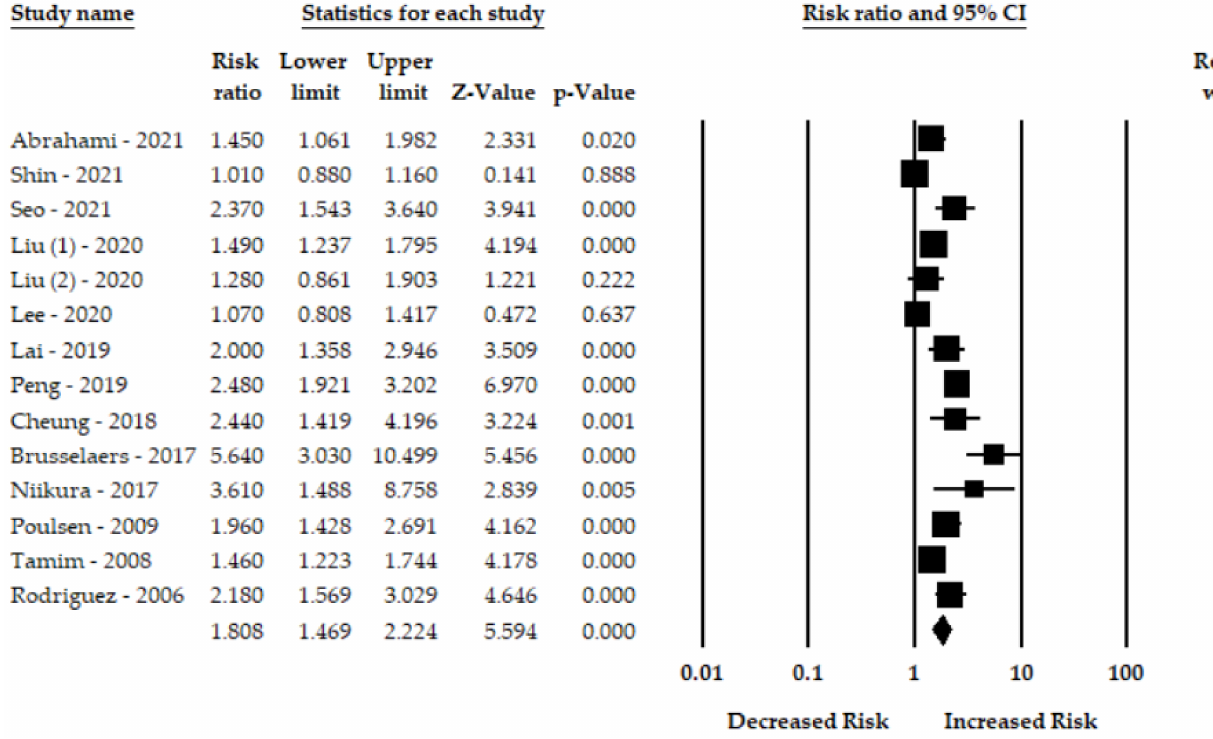
Figure 2. Forest plot of the association between PPIs and risk of gastric cancer